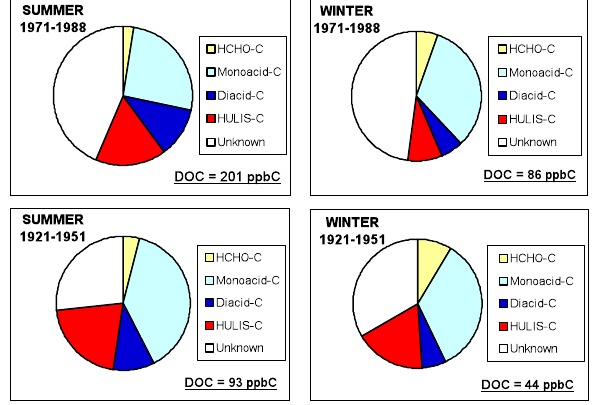
Fig. 9. Chemical composition of DOC present in winter and sum- mer CDK ice layers corresponding to the first (1921–1951) and sec- ond (1971–1988) half of the 20th century. The identified organic species include formaldehyde, C 1 –C 3 monocarboxylic (formic, lac- tic, acetic, glycolic, and glyoxylic) acids, C 2 –C 5 dicarboxylic (ox- alic, malic, malonic, succinic, and glutaric) acids, HULIS, and the unidentified fraction of DOC (see Sect. 4.2). Adapted from Legrand et al.